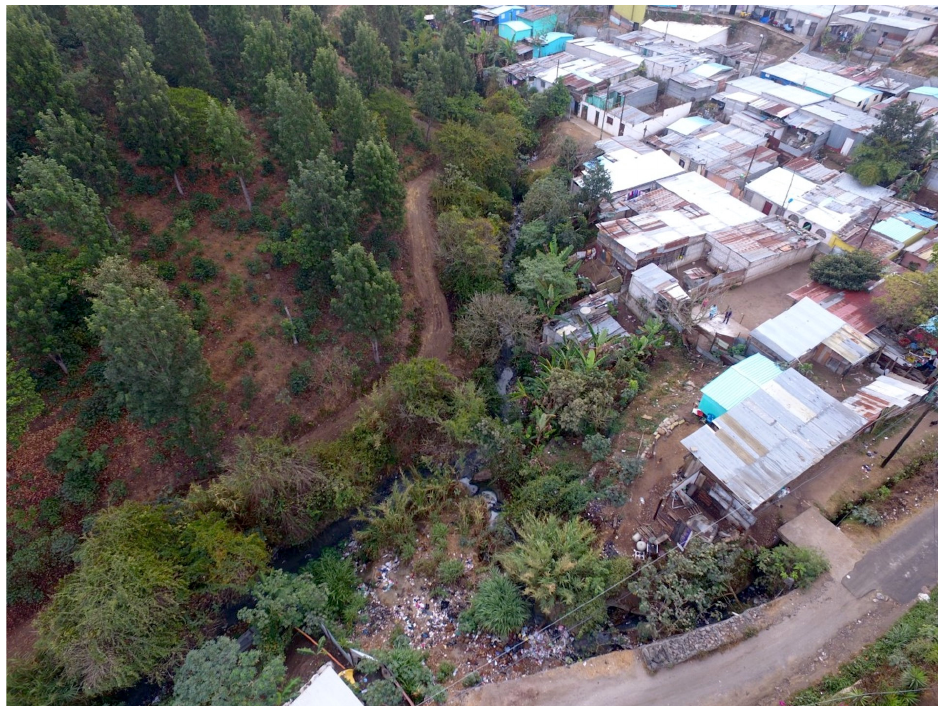
Figure 6. View of the garbage dump in the ravine in 5 de Noviembre, courtesy of